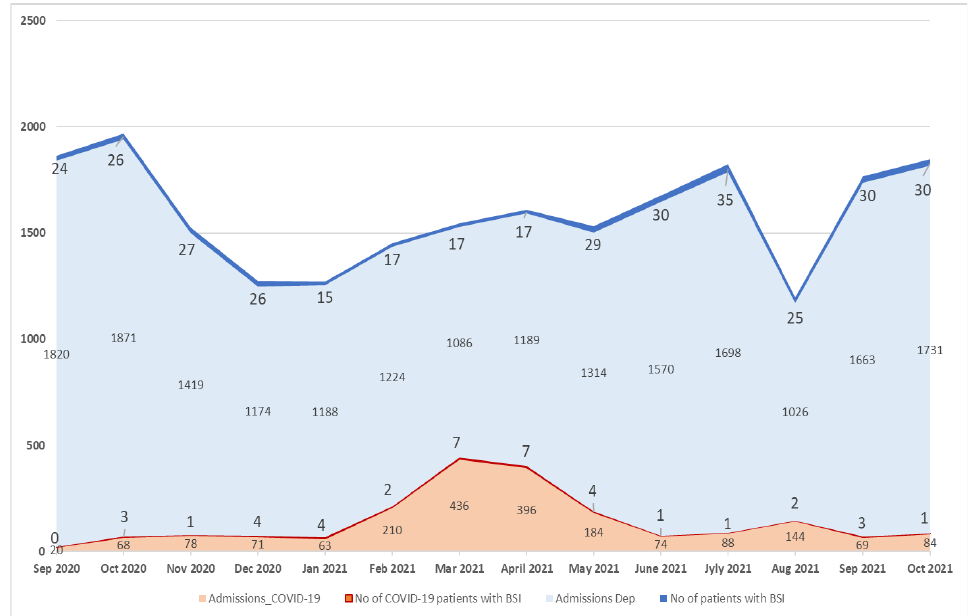
Figure 1. Monthly number of BSI episodes and monthly admissions in COVID-19 and non-COVID-19 departments, except ICU.